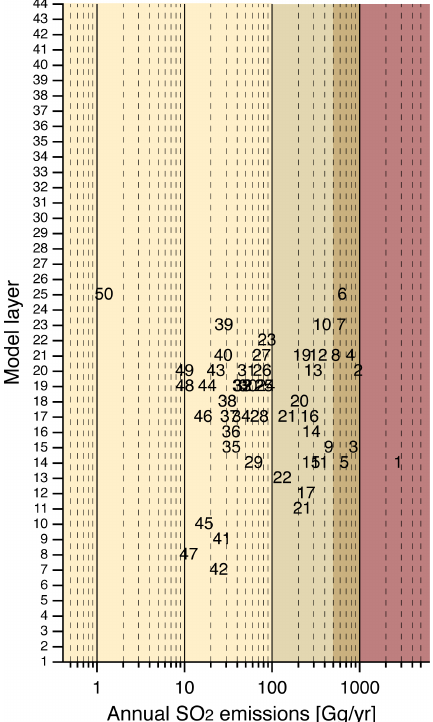
Figure 2. The model layers to which the SO 2 emissions from the 50 volcanoes considered in this study were assigned. See Table 1 for a listing of the volcanoes represented by each number in this figure. In Table 1, volcanoes are listed in decreasing order of their annual SO 2 emission